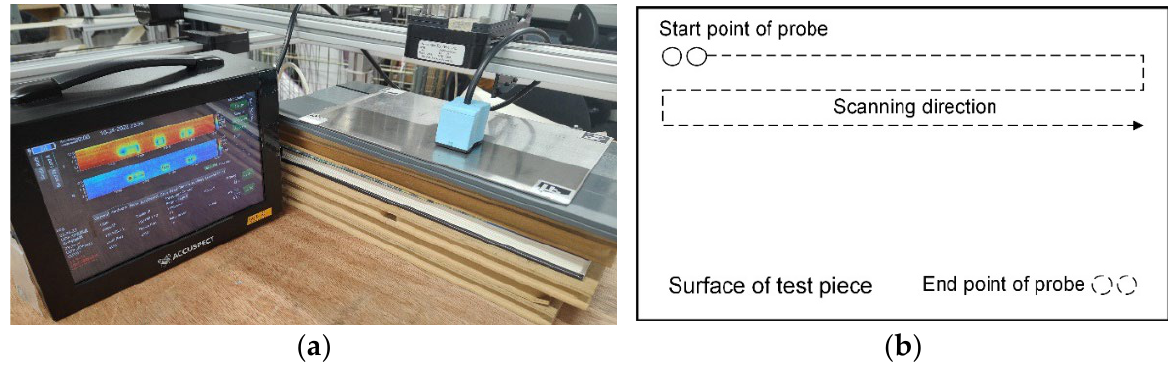
Figure 18. ( a ) Experimental setup of EC system; ( b ) diagram of defect scanning.